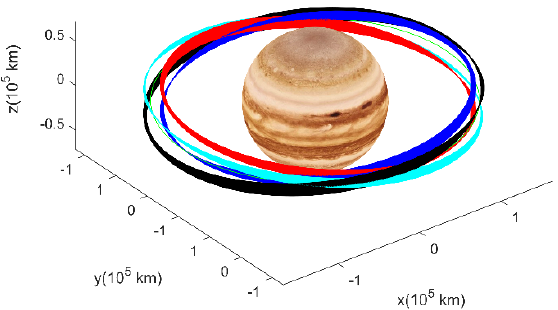
Figure 2. Orbits around Jupiter: green − stationary orbits; red −